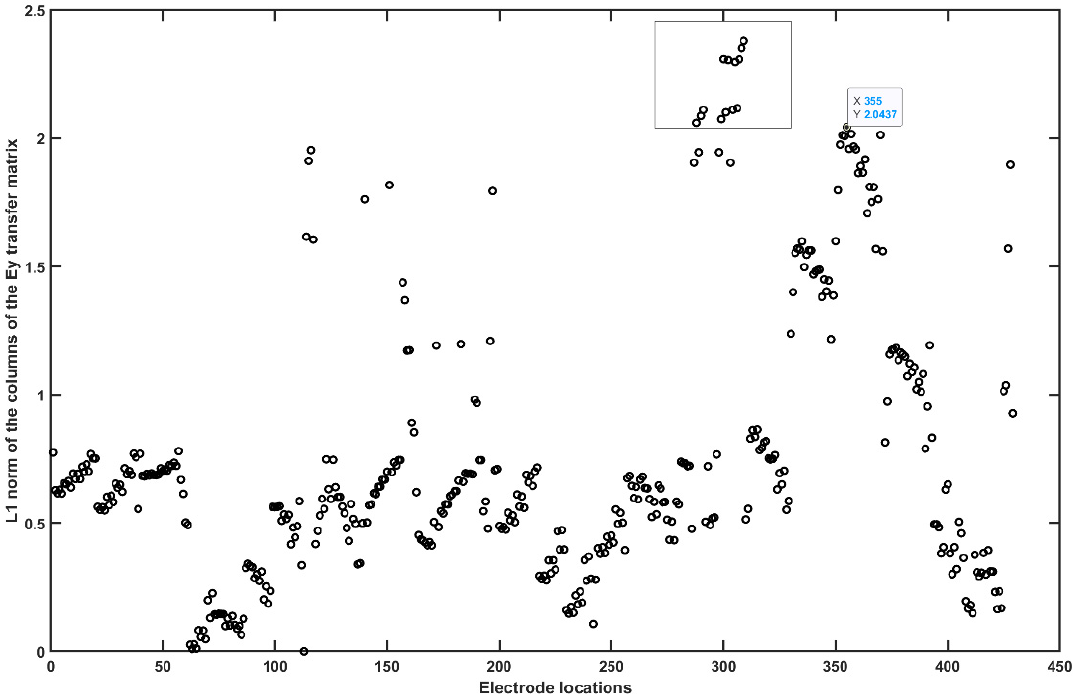
Figure A6. L1 norm of the columns of the Ey transfer matrix without the non-cerebellar brain (i.e. row 35). The rectangle shows the electrode locations with the high L1 norm (electrodes relevant for cerebellar stimulation in Ey).